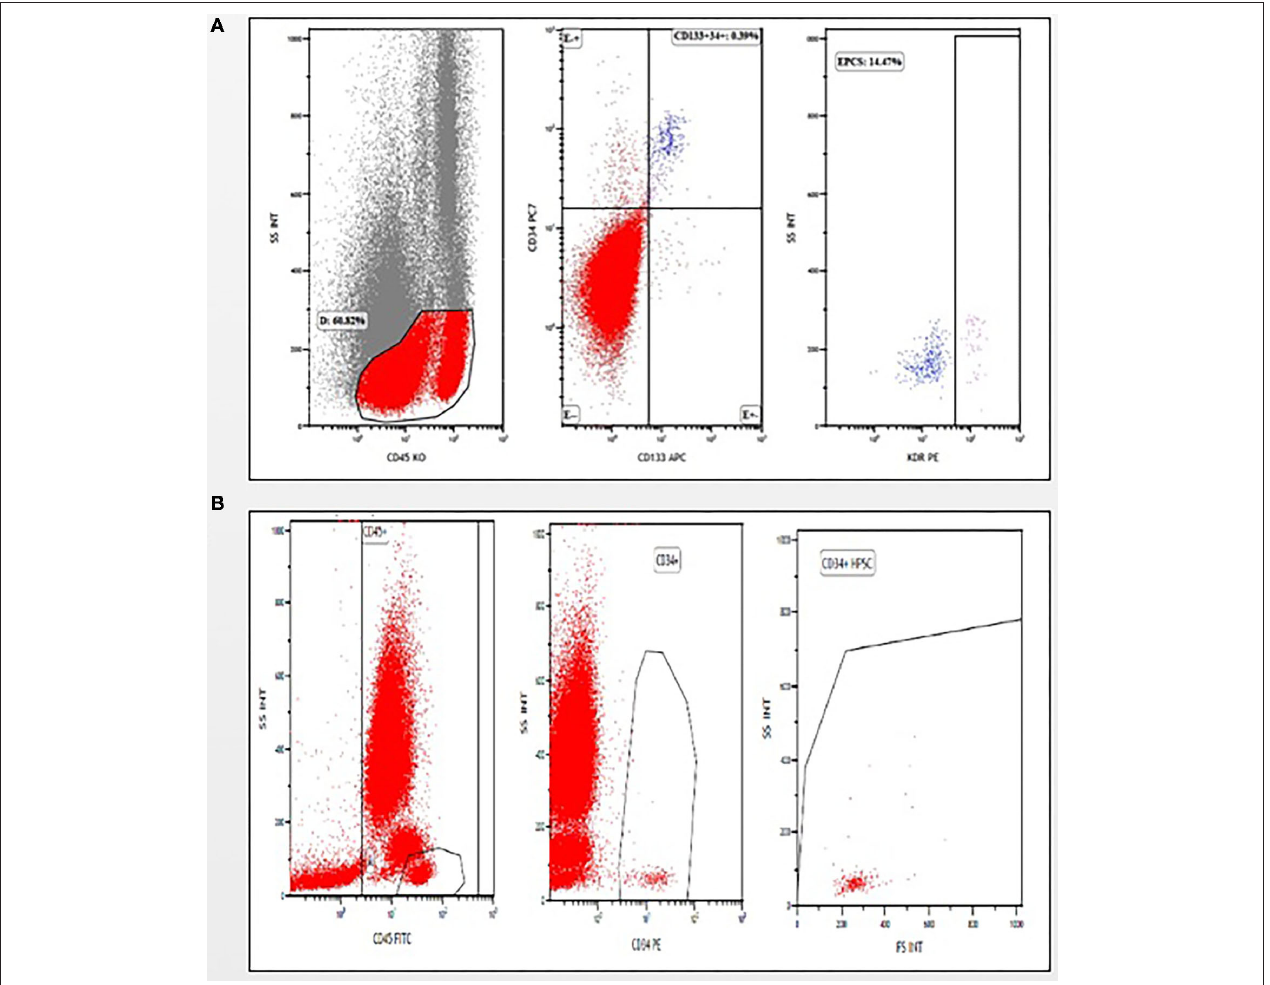
FIGURE 2 | Gating strategies (A) for analyzing CD45 − cells to identify and enumerate endothelial progenitor cells (EPCs) (CD45 − /CD133 + /CD34 + /KDR + ), (B) for analyzing CD45 + cells to identify and enumerate hematopoietic stem cells (HSCs) (CD45 + /CD34 +